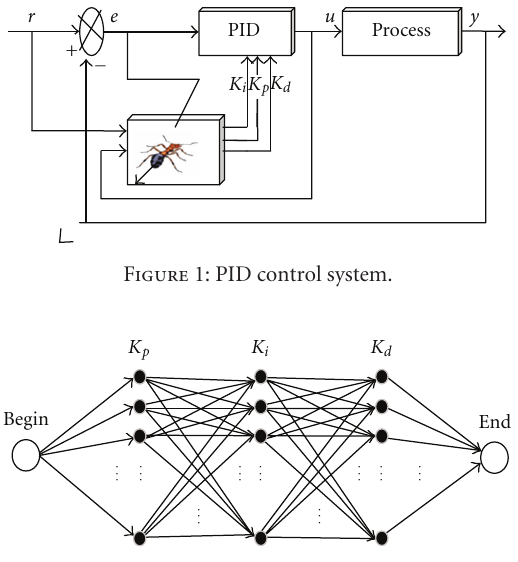
Figure 2: Ant colony optimization graph.